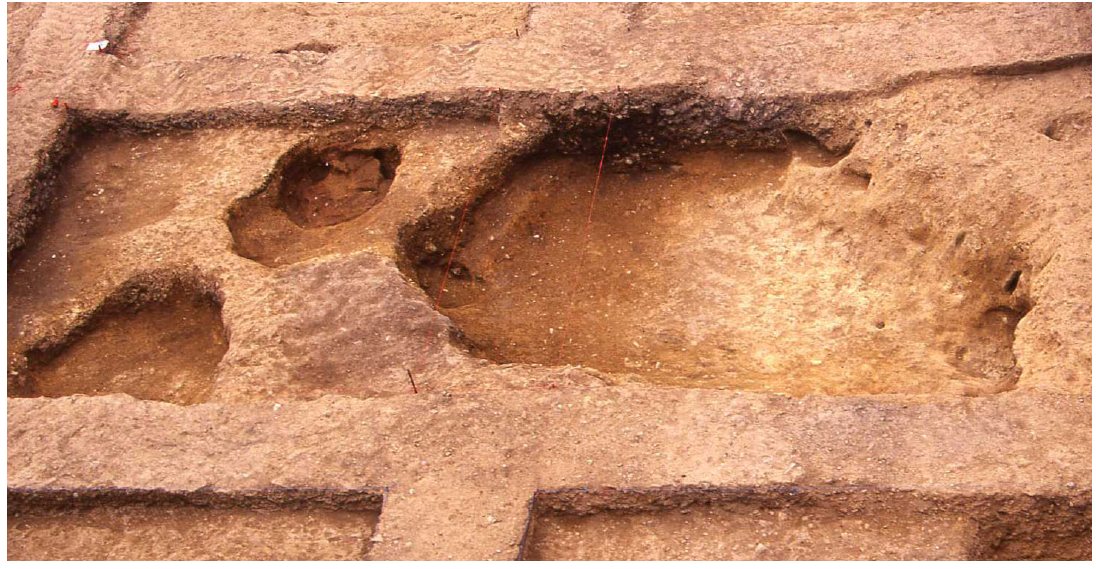
Figure 3. Stavroupoli. The plot of Oreokastrou 98, Stavroupoli Ia (Grammenos, Kotsos 2004).